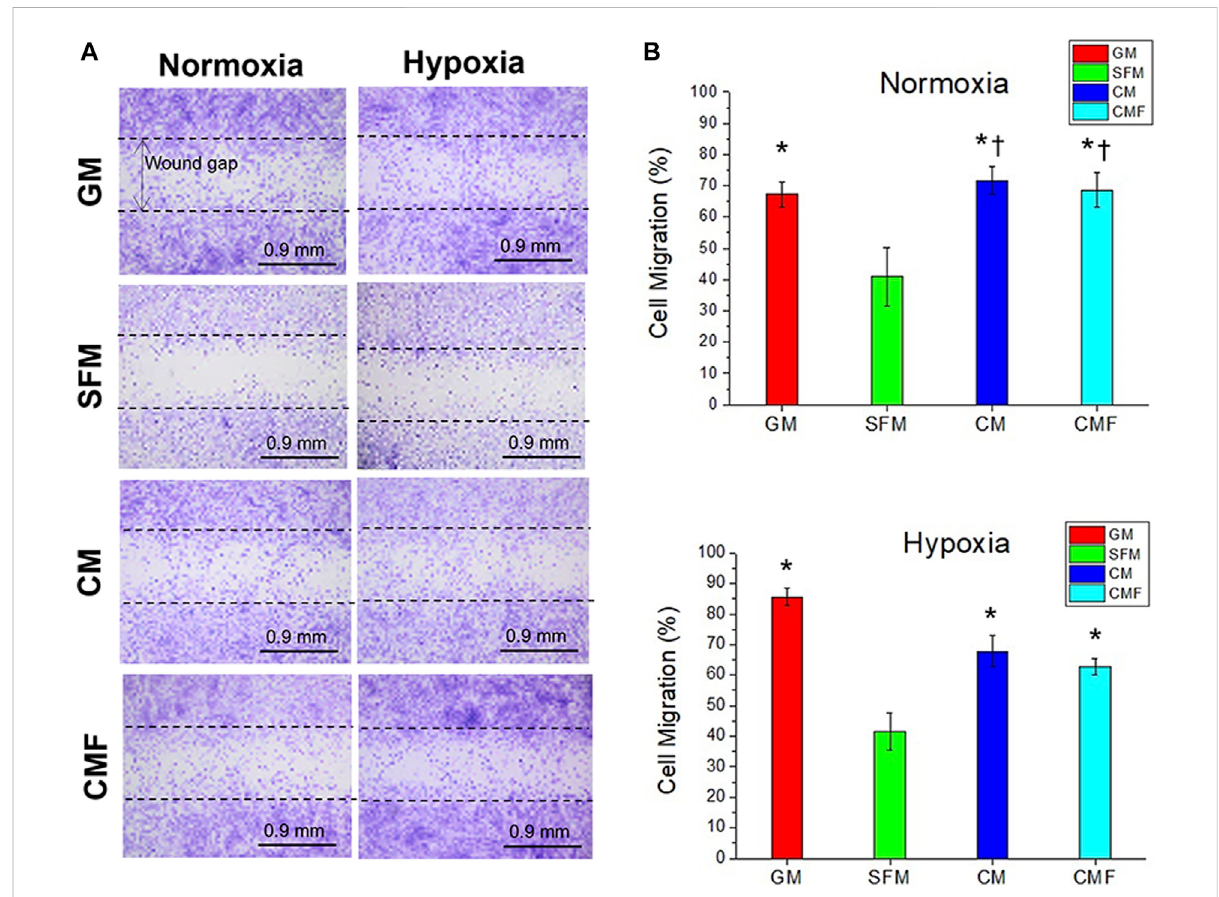
FIGURE 6 In Vitro wound healing assay. HDF migration to the wound gap after 1 day of treatment with GM, SFM, CM (6×), and CMF (6×) in normoxia and hypoxia. (A) Representative images of Cytoselect cell staining. (B) Cell Migration (%). CMF accelerates cell migration and wound closure ( n = 4 per group,6random fi eldspersample,one-wayANOVAandTukey ’ stest,* p < 0.05withSFM. † p > 0.05withGM).Dashlinesindicatetheinitialwoundgap (0.9 mm). Scale bars: 0.9